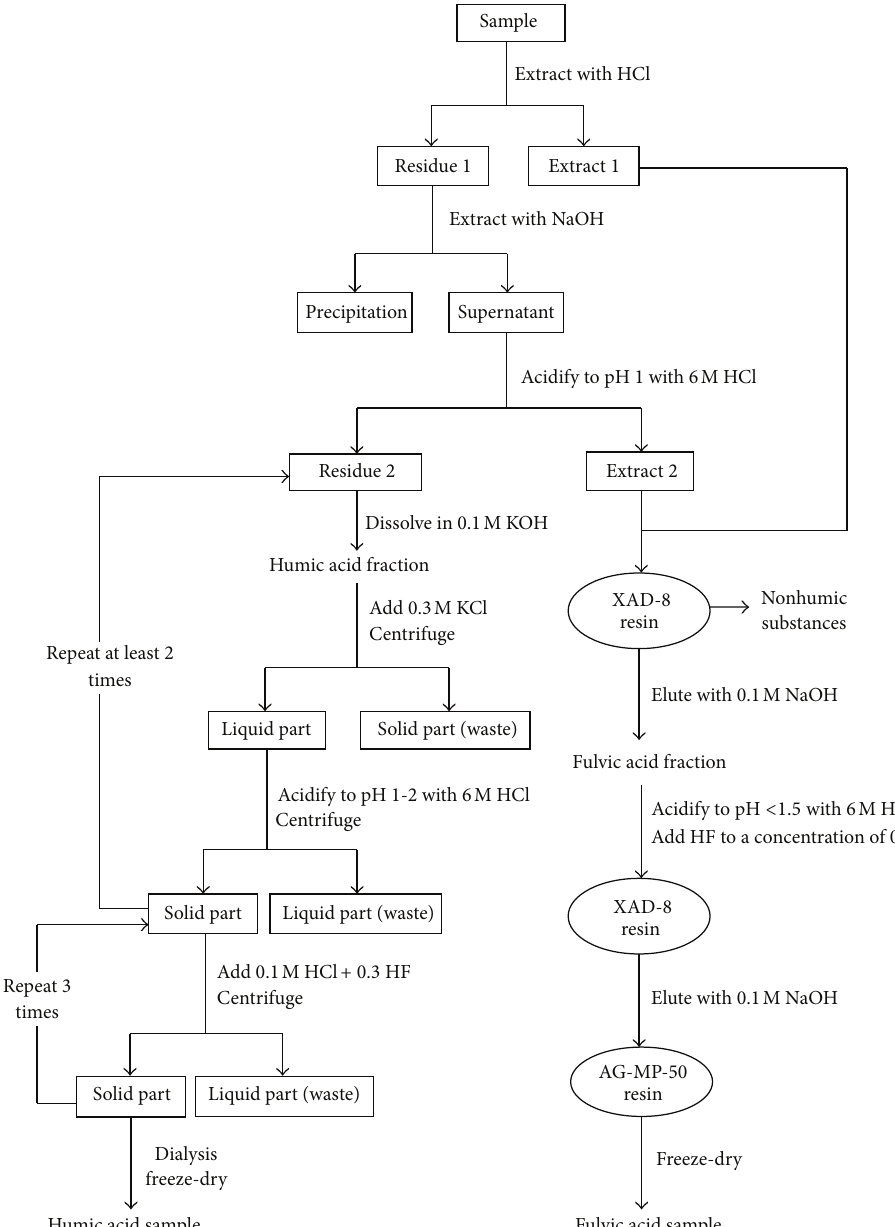
Figure 1: Schematic diagram of fractionation of humic substances and nonhumic substances.